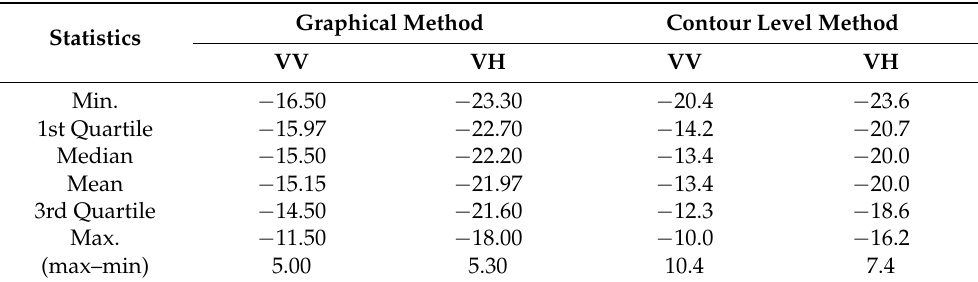
Table 6. VV and VH threshold statistics: (1) obtained via graphical interpretation and (2) calculated based on the intersection of the observed water elevation contour line over SAR